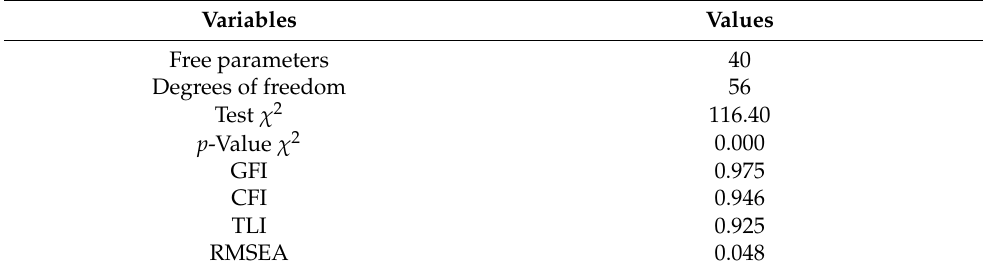
Table 2. Results of the evaluation of the measurement